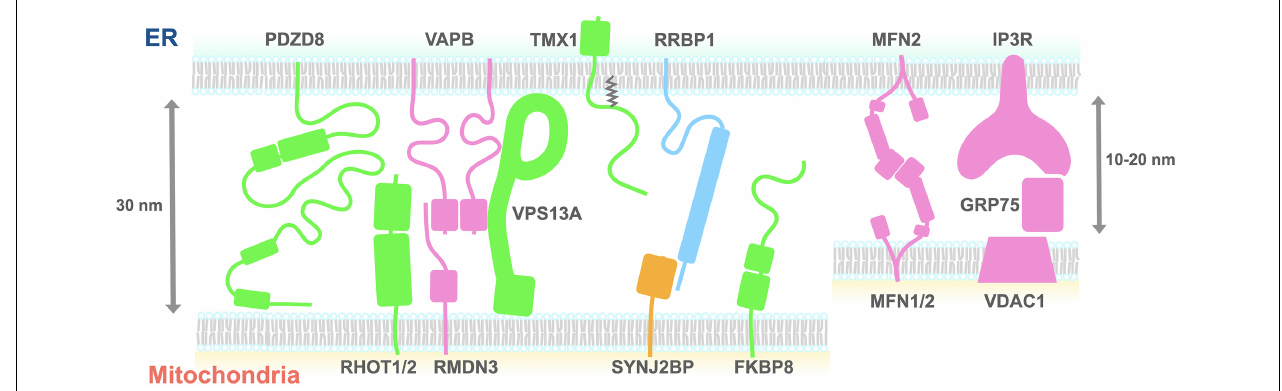
FIGURE 1 | A schematic diagram of the proteins proposed to tether the ER and mitochondria. The size of each domain structure was either calculated from the structures deposited on the Protein Data Bank or estimated using the Phyre2 protein structure prediction tool. Proteins shown to be necessary (green, pink) or sufficient (yellow) for tethering the ER and mitochondria are depicted. Green indicates that tethering partners of the proteins remain to be determined. Light blue indicates that roles of the proteins need to be determined. ER, endoplasmic reticulum; FKBP8, FK506-binding protein 8; IP3R, inositol 1,4,5-trisphosphate receptor; Mfn2, mitofusin 2; PDZD8, PDZ domain-containing protein 8; RHOT1, Ras homolog family member T1; GRP75, glucose-regulated protein 75; RMDN3, regulator of microtubule dynamics protein 3; RRBP1, ribosome-binding protein 1; SYNJ2BP, synaptojanin-2-binding protein; TMX1, thioredoxin-related transmembrane protein 1; VAPB, VAMP-associated protein B; VPS13A, vacuolar protein sorting-associated protein 13 A; VDAC, voltage-dependent anion